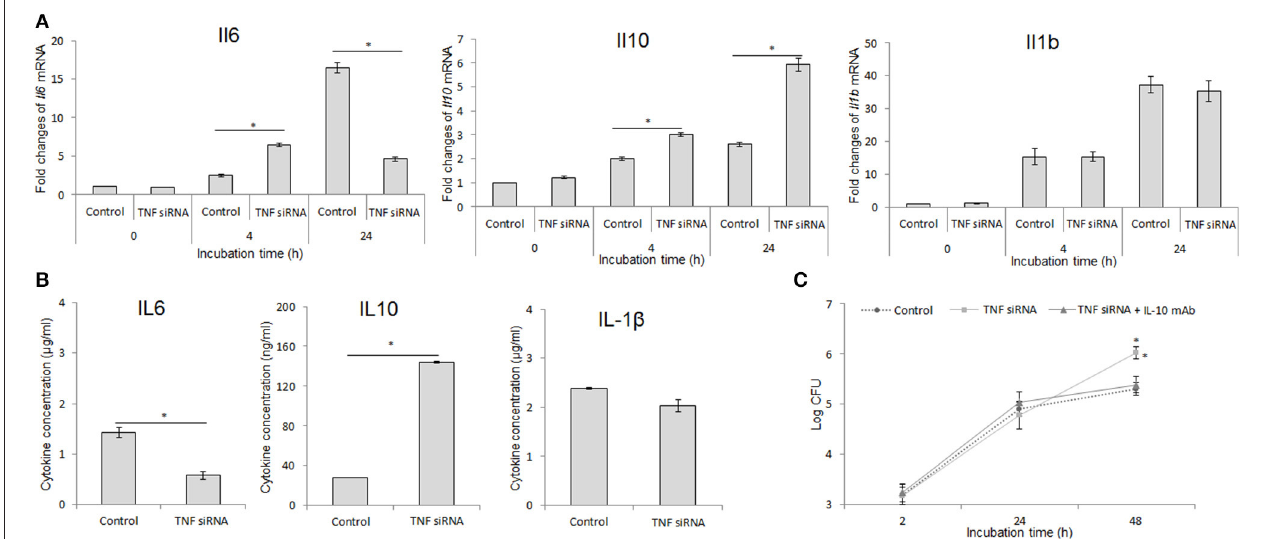
FIGURE 2 | Inhibition of IL-10 signaling significantly restored the antimicrobial effect in TNF-lacking cells. Macrophages were treated with TNF siRNA prior to B. abortus infection. Total RNA content was isolated and the expressions of inflammatory cytokines including Il6, Il10, and Il1b were evaluated by RT-PCR at different time points (A) . The presence of secreted cytokines was also checked by Western blot at 48h pi (B) . The TNF-blocking cells were infected with B. abortus and treated with anti-IL-10 antibody. The intracellular growth of B. abortus within macrophages was then evaluated (C) . Data represent the mean ± SD of triplicate experiments. Asterisk indicated the significant difference ( P <